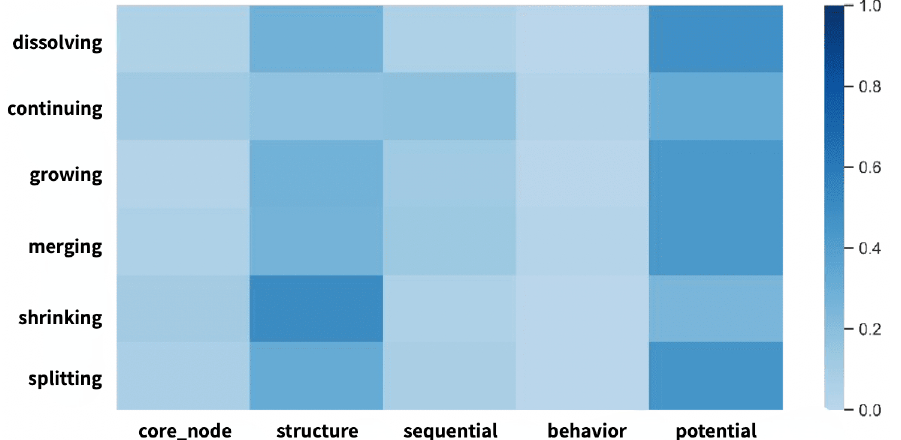
Figure 5. Distribution of importance of various features in the Hepth data